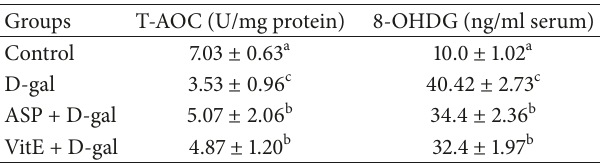
Table 2: Effect of ASP on the content of T-AOC and 8-OHDG in Sca-1 + HSC/HPCs of aging model mice.